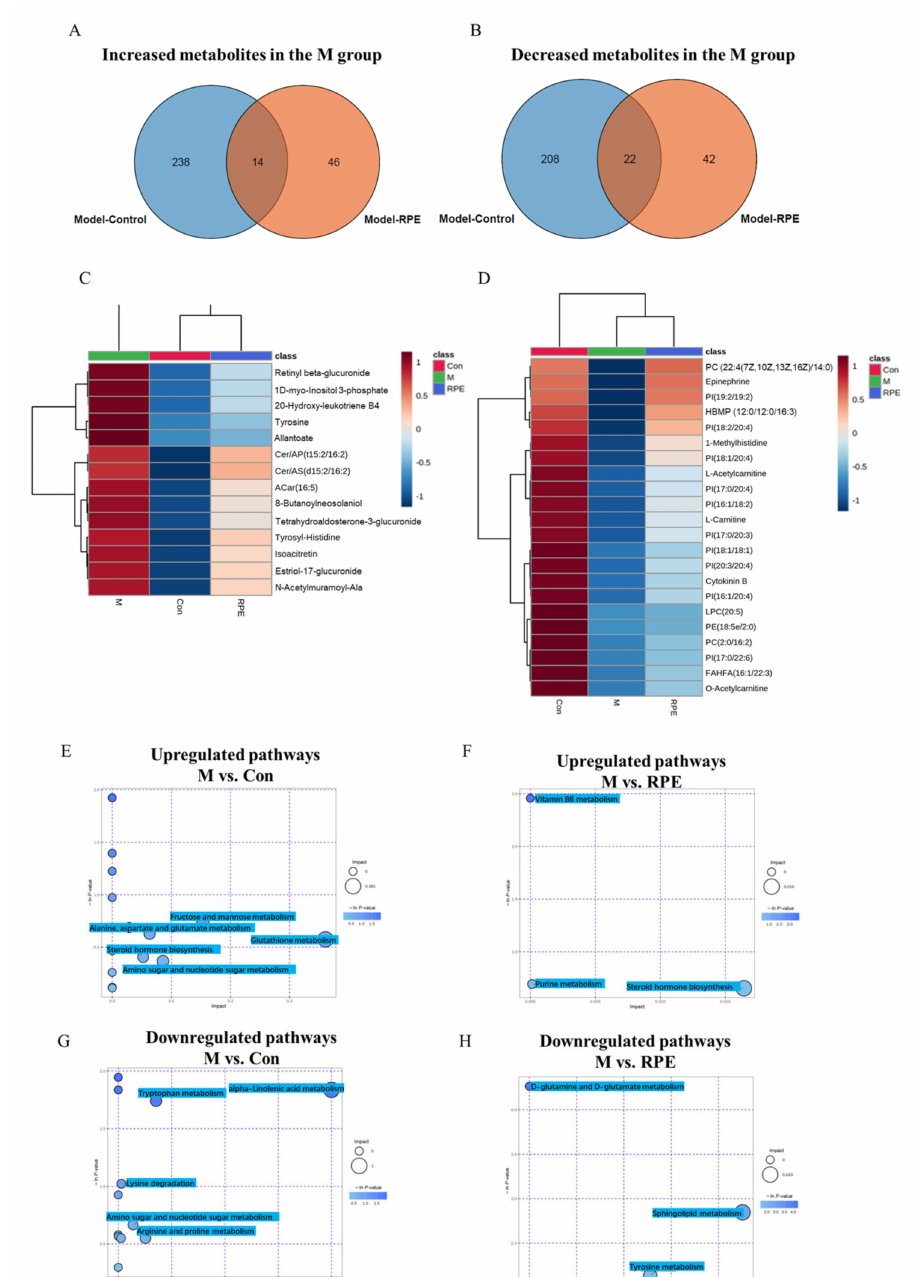
Figure 3. Venn diagrams showing the number of increased metabolites in the M group compared to the Con groups were decreased by RPE ( A ) and the number of decreased metabolites in the M group compared to the Con groups were increased by RPE ( B ). Increased metabolites in diabetes that were reversed by RPE ( C ). Decreased metabolites in diabetes that were reversed by RPE ( D ). KEGG pathway enrichment analysis based on increased metabolites in M/Con ( E ) and M/RPE ( F ) comparisons. KEGG pathway enrichment analysis based on decreased metabolites in M/Con ( G ) and M/RPE ( H )